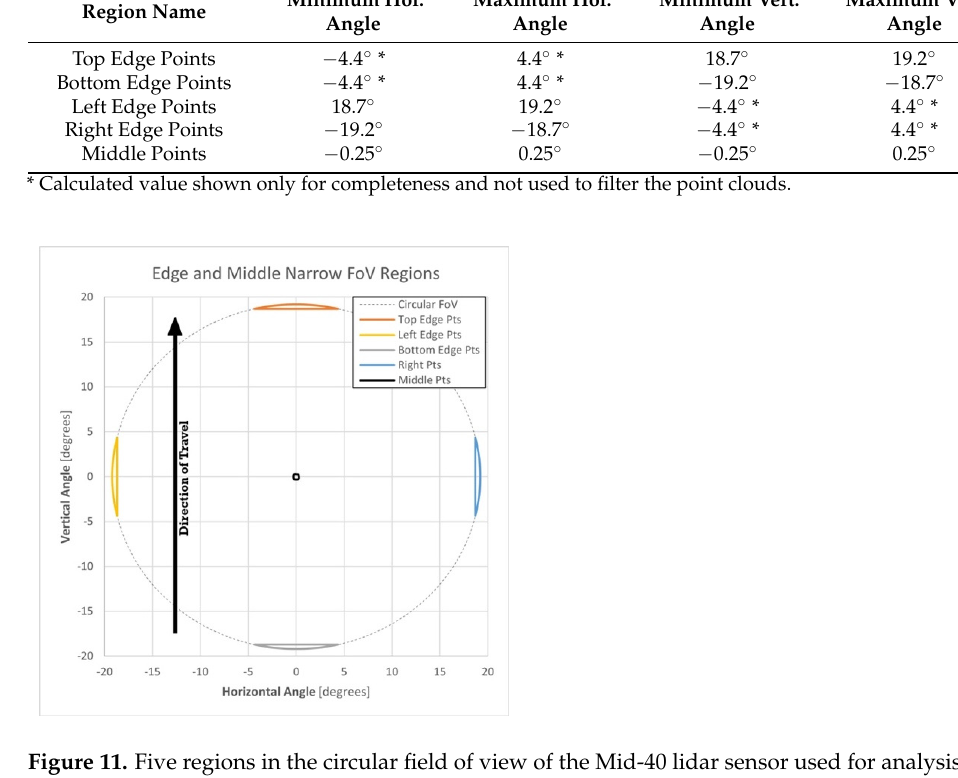
Table 6. Regions in the circular field of view of the Mid-40 lidar sensor used for analysis. Minimum Hor. Region Name